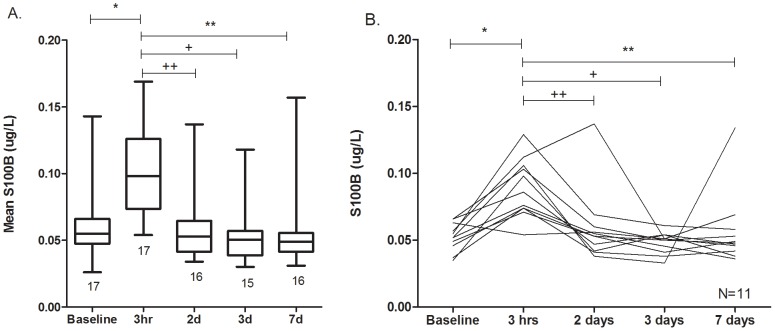
Longitudinal changes in S100B before and after sports-related concussion.
A: Mean changes in S100B levels among all concussed athletes at baseline and at four time points after injury. The number of athletes included in determining the mean at each time point is indicated below each box plot. The mean S100B concentration within 3 hours of SRC (0.099±0.032 µg/L) was significantly higher than that at baseline (0.058±0.025 µg/L, *p<0.0001) using a paired t-test. The 3 hour S100B level was also higher than that at 2 days (0.059±0.03 µg/L, ++p = 0.0004), 3 days (0.052±0.02 µg/L, +p<0.0001), and 7 days (0.059±0.03 µg/L, **p = 0.001) post-SRC using unpaired t-tests. B: Longitudinal changes in S100B levels among concussed athletes who had baseline and all four post-SRC S100B measurements. All 11 of these athletes were from the Unviersity of Rochester. The mean S100B level within 3 hours of SRC (0.099±0.032 µg/L) was significantly higher than that at baseline (0.058±0.025 µg/L, *p<0.0001), and higher than that at 2 days (0.059±0.027 µg/L, ++p = 0.0047), 3 days (0.048±0.008 µg/L, +p = 0.0002), and 7 days (0.056±0.027 µg/L, **p = 0.0058) post-SRC using paired t-tests.